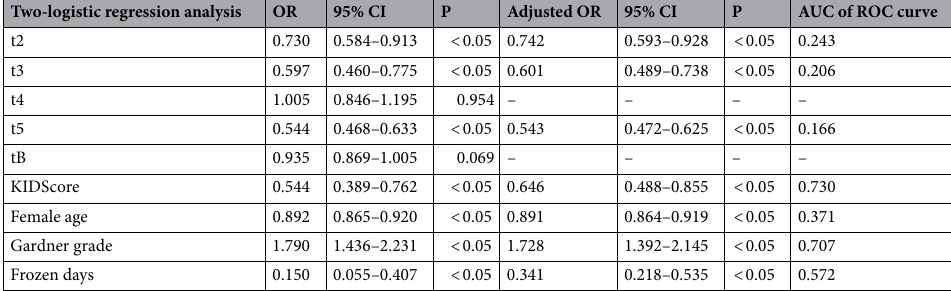
Table 5. Relationship between characteristics and euploid by two-logistic regression and ROC curve analysis.